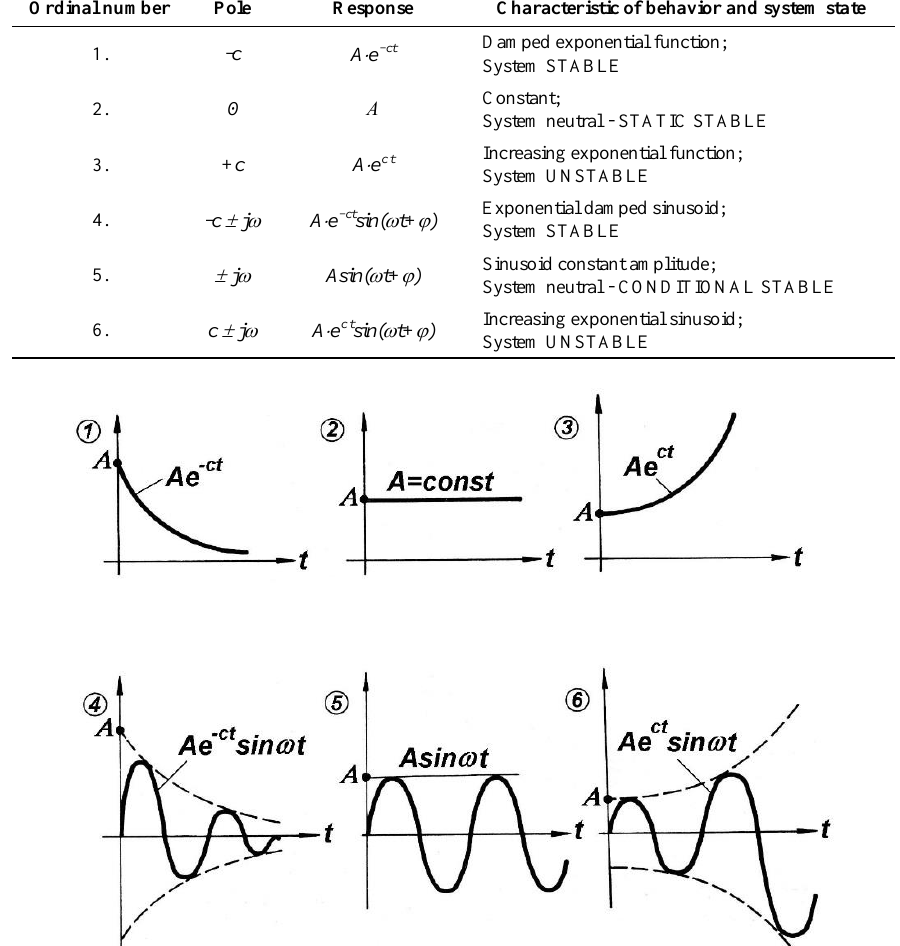
Figure 10. Typical system responses for cases listed in Table